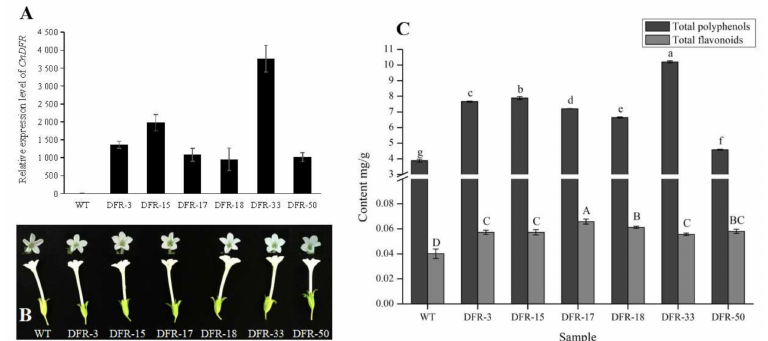
Figure 5. Relative expression of CnDFR and contents of total flavonoids, total polyphenols and total anthocyanins in flowers of transgenic tobaccos. ( A ) The expression of CnDFR in tobacco flowers. CnDFR expression of transgenic lines was significantly higher than the wild type. ( B ) Flowers of wild type and transgenic tobaccos. The flowers of wild type and transgenic strains were white with no significant di ff erence. ( C ) The contents of total polyphenols and total flavonoids. Total polyphenols in most of transgenic strains were about twice the wild type. Total flavonoids were very low overall, and the contents in transgenic strains were 1.5 times the wild type. The letters represent the level of di ff